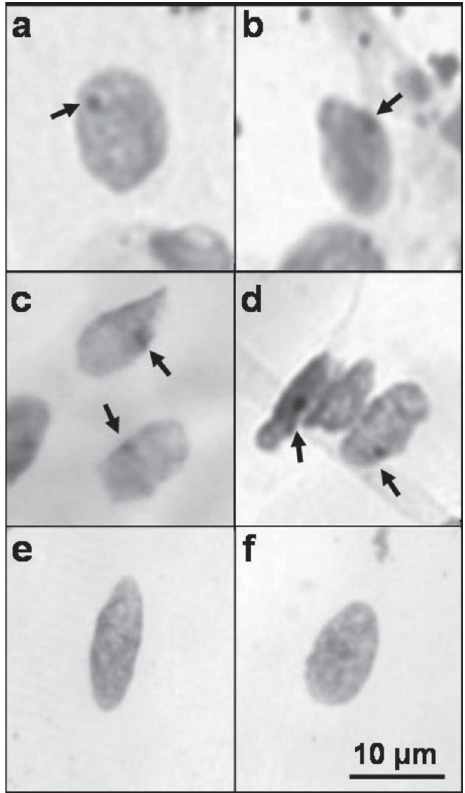
Figure 1. Ectopic development of skeletal muscle induced by subcutaneous transplantation of rat satellite cells. Satellite cells (10 6 cells) obtained from hindlimb muscles of newborn female rats were injected subcutaneously into the dorsal region of adult male rats. After 7 days, the transplants were removed, processed and stained with hematoxylin and eosin (HE) (a,b; Bars, 1 cm). A tissue mass formed under the skin of adult male rat after transplantation of satellite cells. Cross-sections (c,d,g) or longitudinal sections (e,f) of transplanted tissue (c-f) or extensor digitorum longus muscle from an adult male rat (g), stained with HE (Bars, 50 µm). The arrows indicate the presence of vascular formation (a,b) and the central nuclei (c,d).